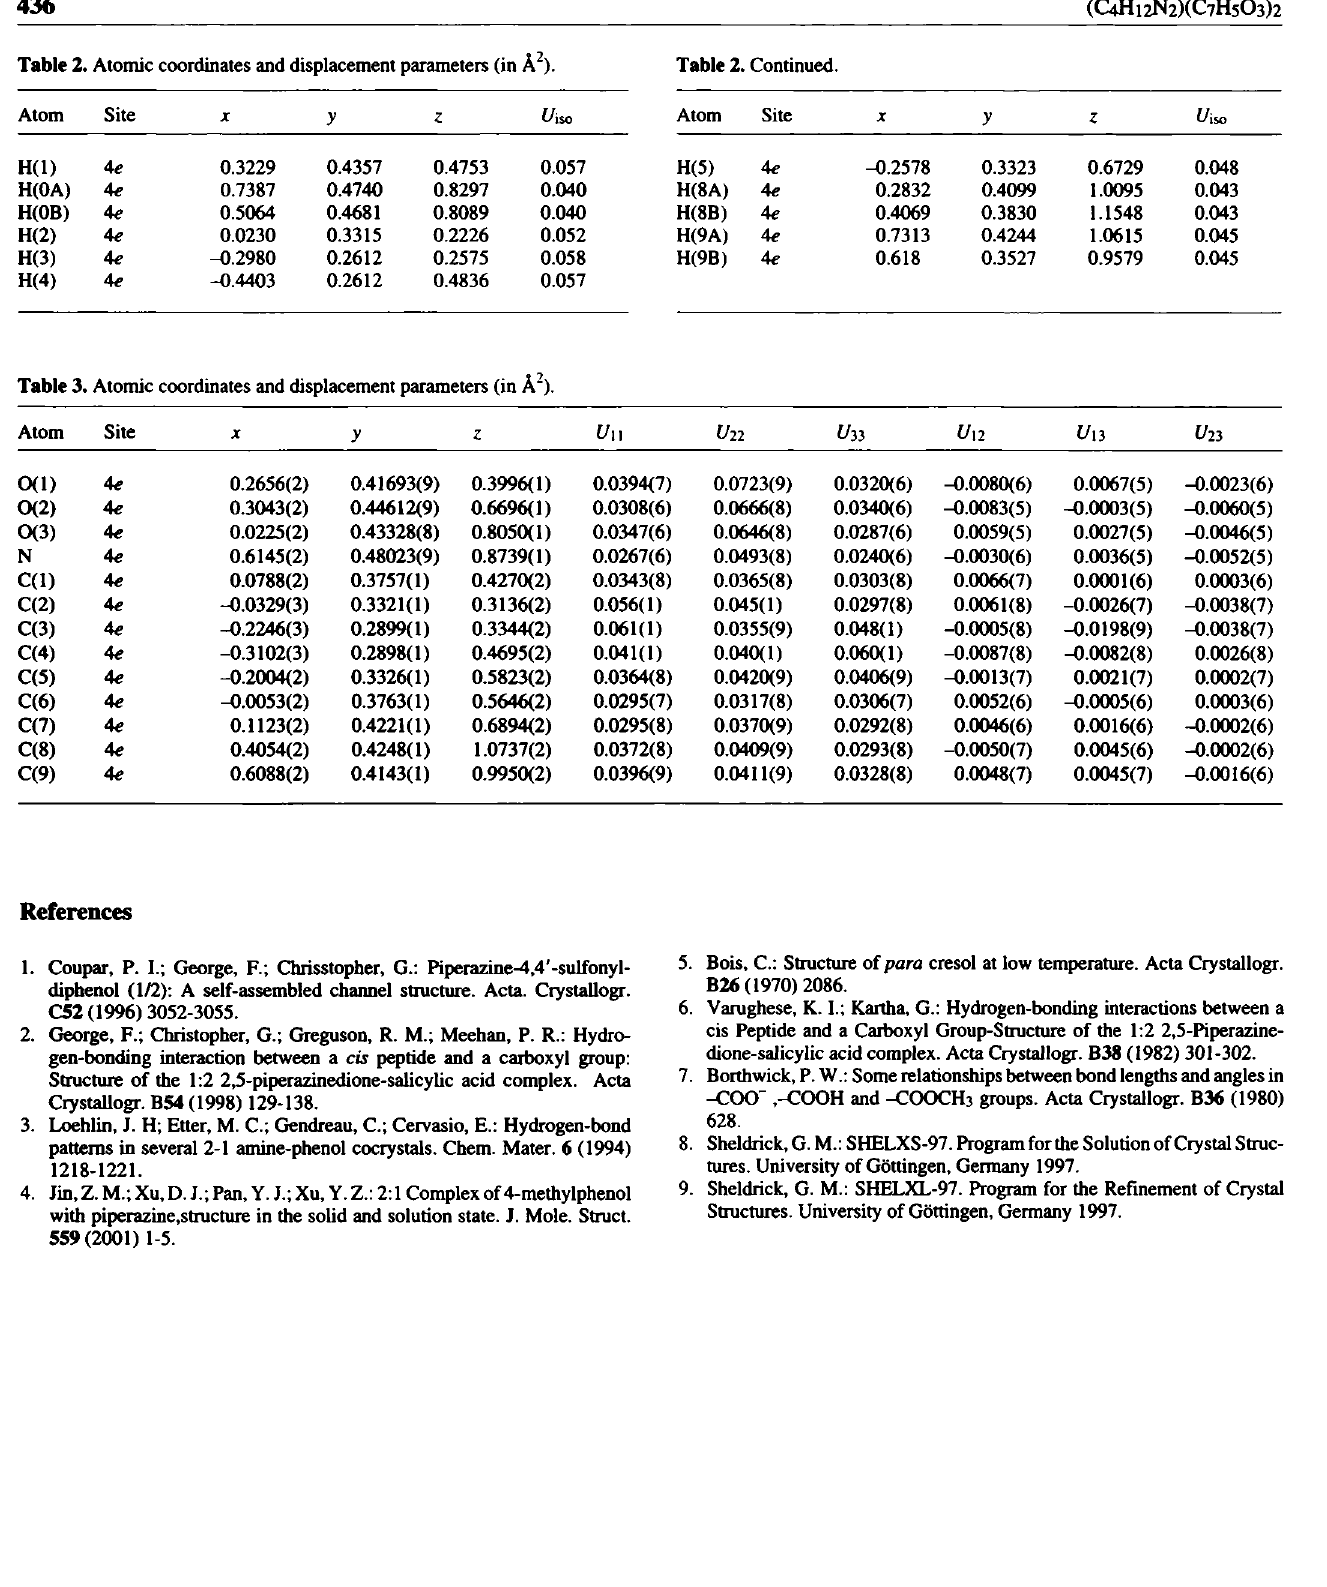
Table 2. Atomic coordinates and displacement parameters (in Ä 2 ).